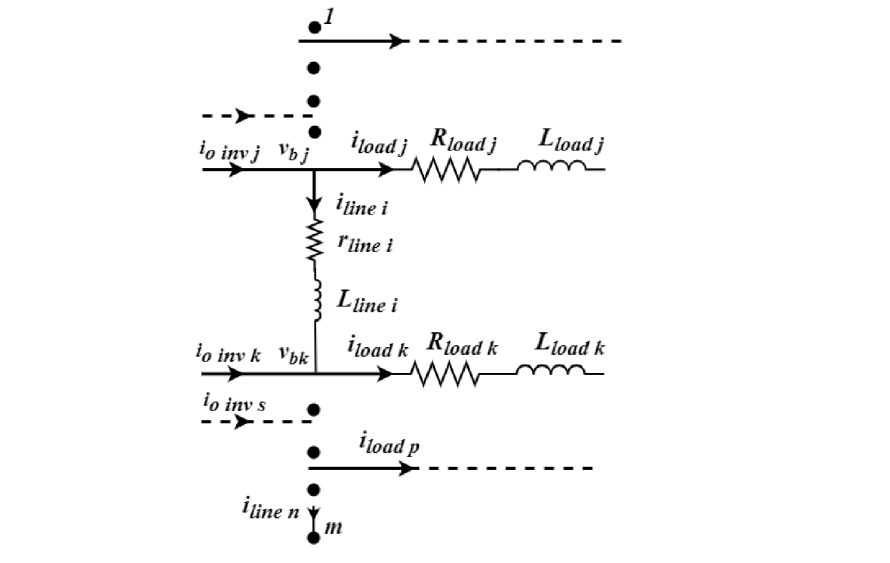
Figure 3. Network topology of inverter-based microgrid model